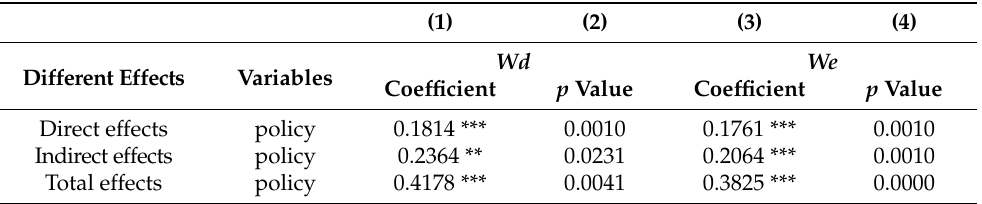
Table 5. Direct, indirect, and total effects of the SDM-SDID